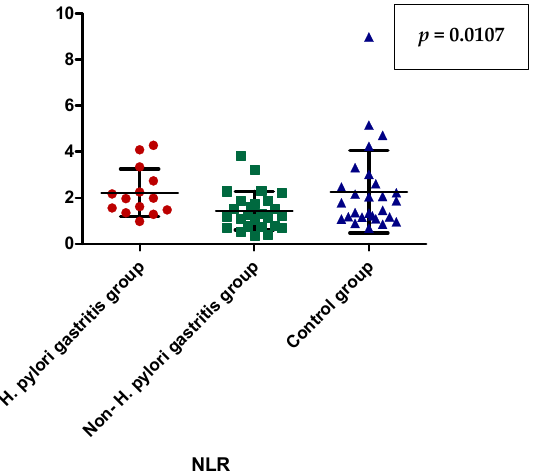
Figure 1. The difference of median values of NLR between the three groups. Although we found no significant differences regarding mean corpuscular hemoglobin concentration (MCHC) among the three groups, when comparing the group of H. pylori -induced gastritis group to non- H. pylori gastritis group, we noticed a significantly higher value of this parameters in H. pylori -induced gastritis group (0.0499). Similarly, we also found a significantly higher value in non- H. pylori gastritis group when compared to control group ( p = 0.0489) (Table 4 and Figure 2). Table 4. The difference of median values of MCHC between the three groups.